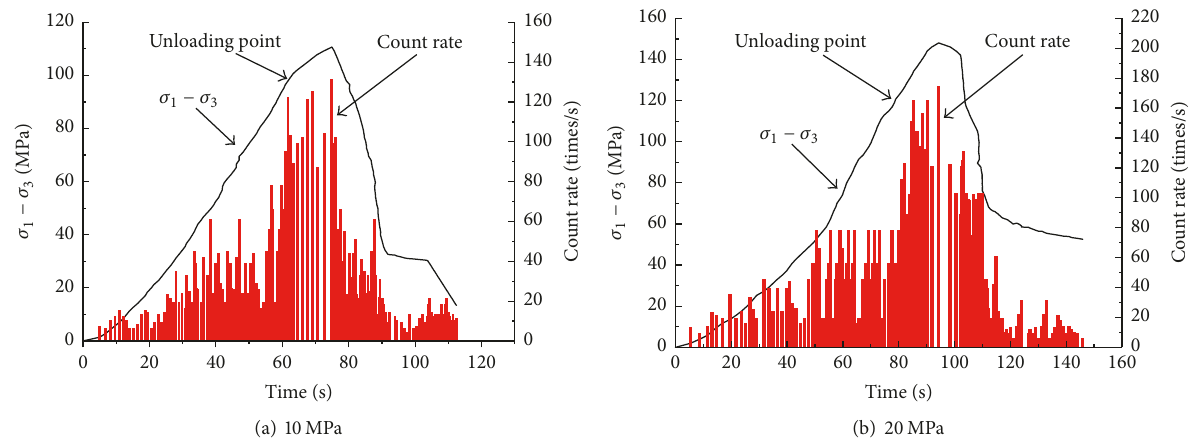
Figure 4: Curves of axial stress difference and count rate with time in sandstone failure process under various confining pressures in Scheme II.